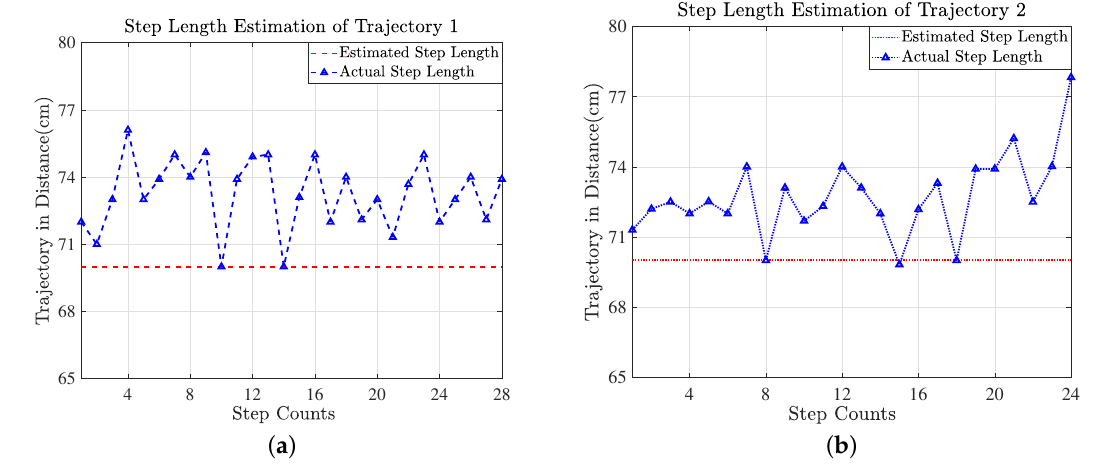
Figure 14. Estimated and actual paths of ( a ) trajectory 1 and ( b ) trajectory 2. Table 2. The comparison of the previous related studies and the proposed study in terms of indoor navigational performance. Proposed Algorithm Signal Source Error in